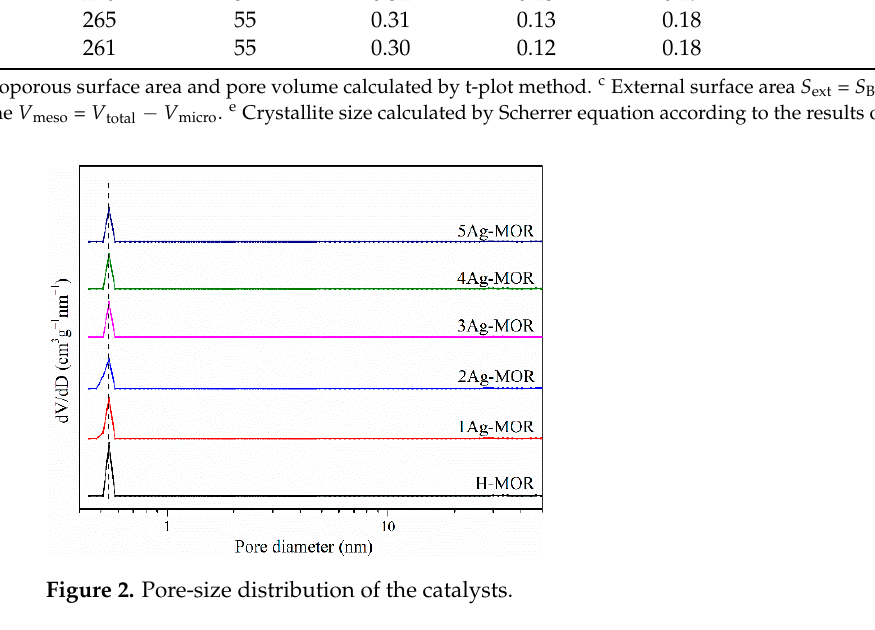
Figure 2. Pore ‐ size distribution of the catalysts. Figure 2. Pore-size distribution of the Table 1. Textural properties of the catalysts.